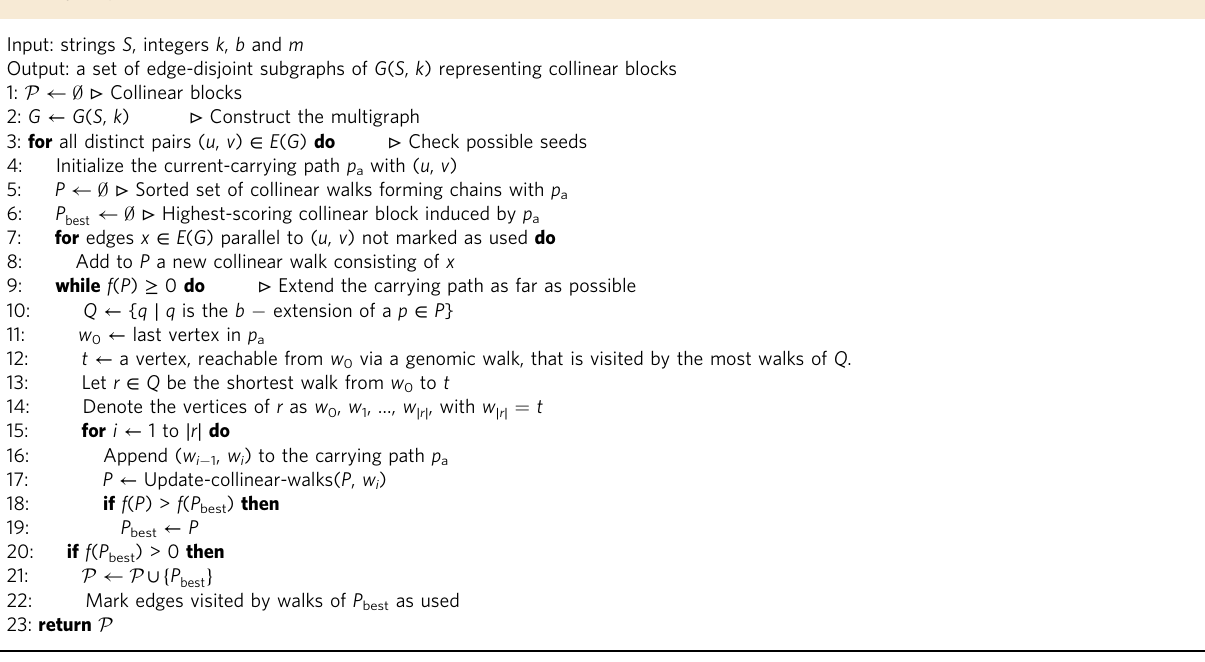
Box 1 | Algorithm